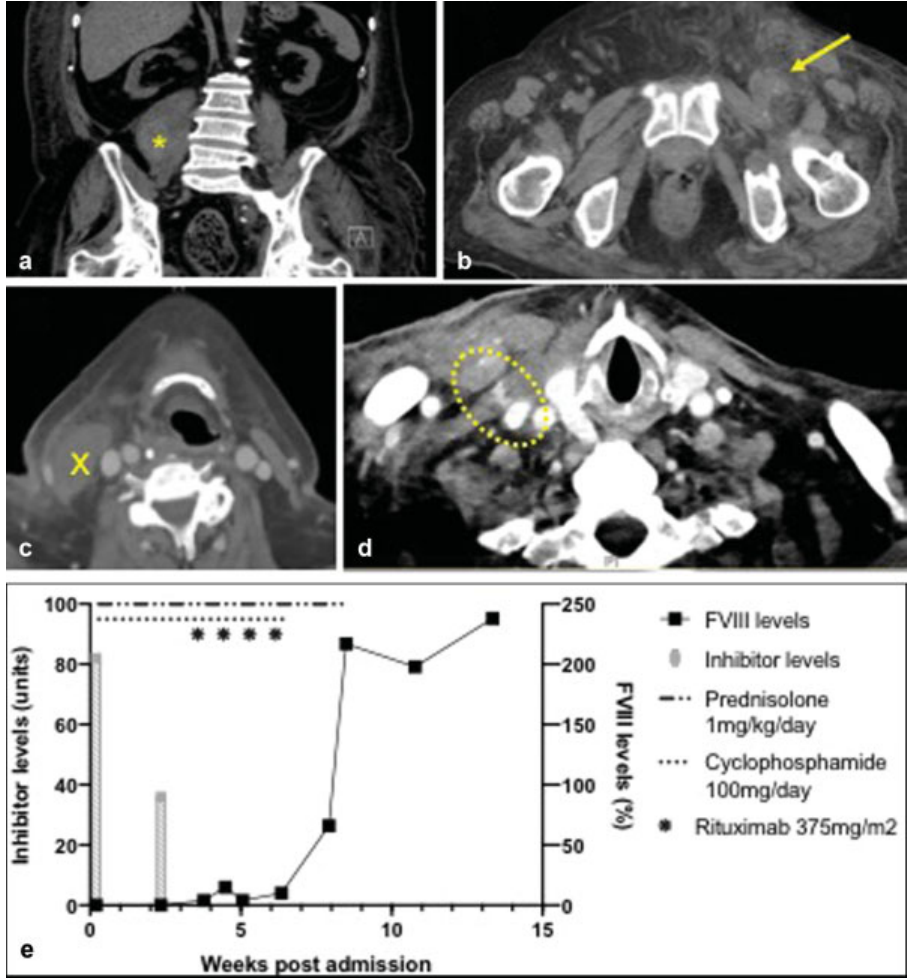
Fig. 1 Simultaneous presentation of bleeding and thrombosis. ( a, b ) Noncontrast CTscan of abdomen and pelvis demonstrating ( a ) right psoas swelling, depicted with star , and ( b ) obliteration of the left femoral vein ( arrow ); ( c, d ) CT neck with contrast demonstrating ( c ) a hematoma overlying the right sternocleidomastoid ( cross ) and ( d ) contrast extravasation from the right IJV puncture site; ( e ) Serum FVIII and inhibitor levels with respect to immunosuppression therapy. CT, computed tomography; IJV, internal jugular